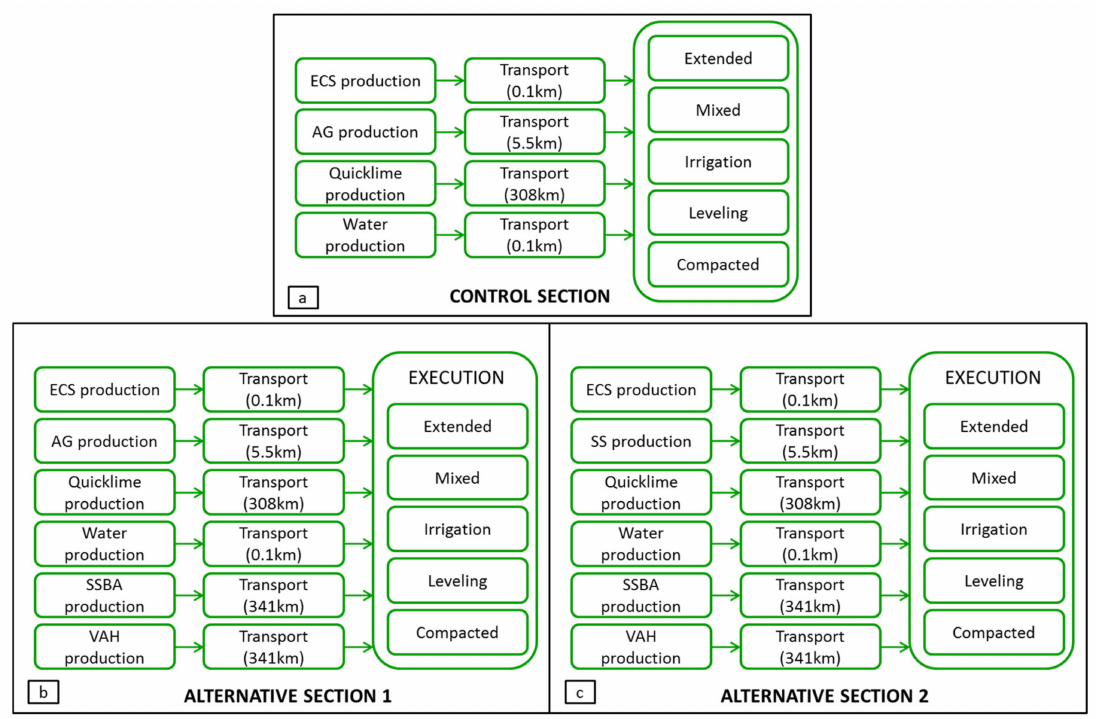
Figure 13. System boundaries: ( a ) Control Section; ( b ) Alternative section 1; ( c ) Alternative section